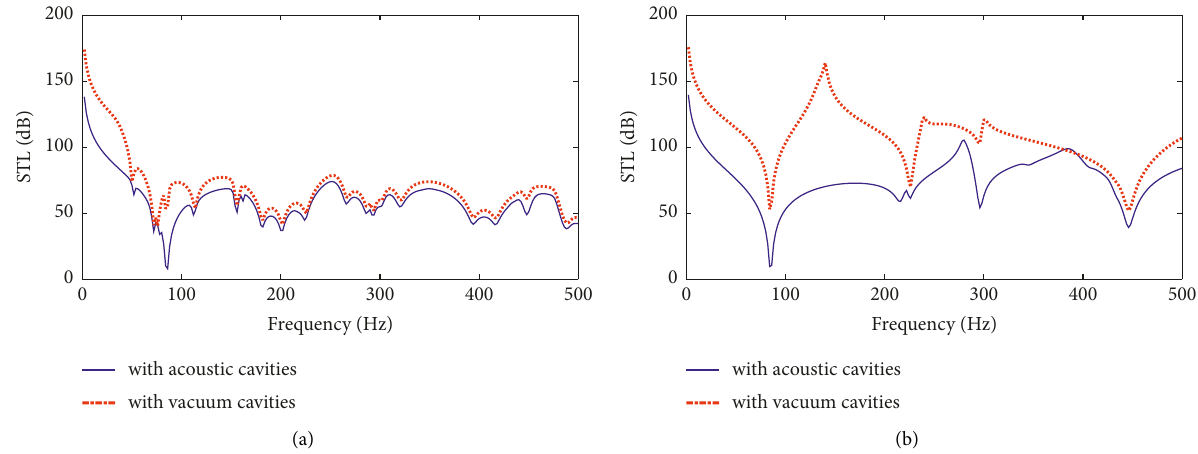
Figure 24: Sound transmission loss of the stiffened double panel structure with acoustic and vacuum cavities: (a) acoustic excitation at elevation angle φ � π /4 and azimuth angle θ � π /4 and (b) acoustic excitation perpendicular to panel